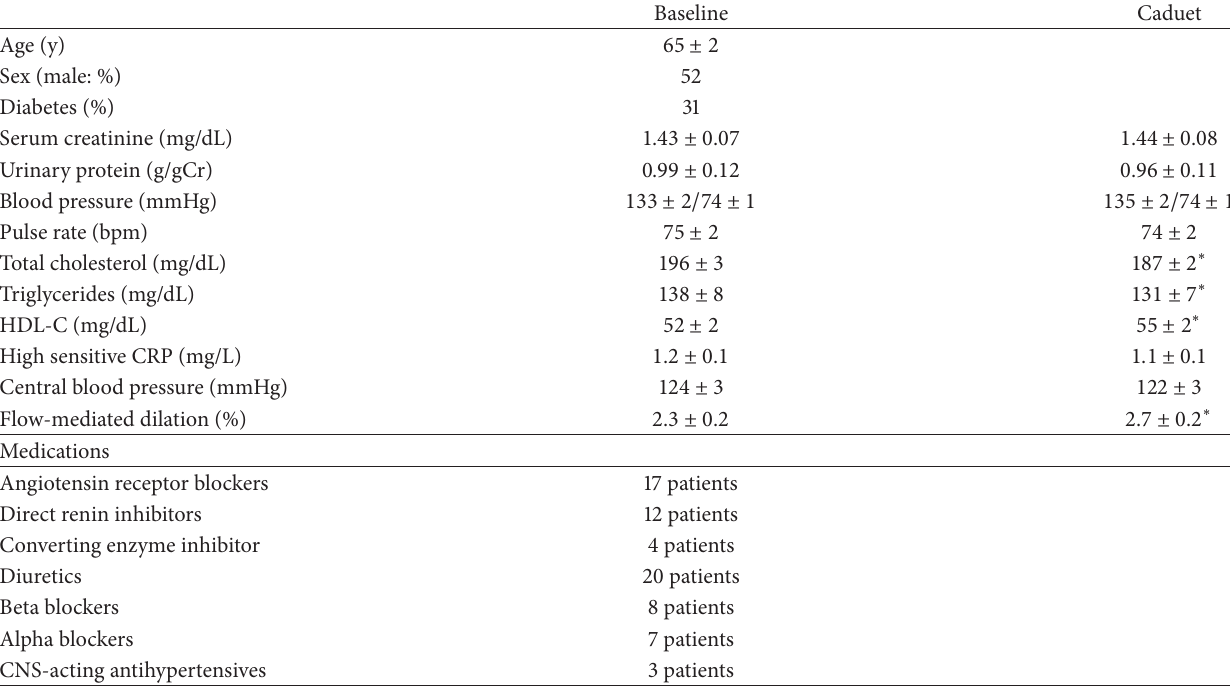
Table 1: Data on study patients.